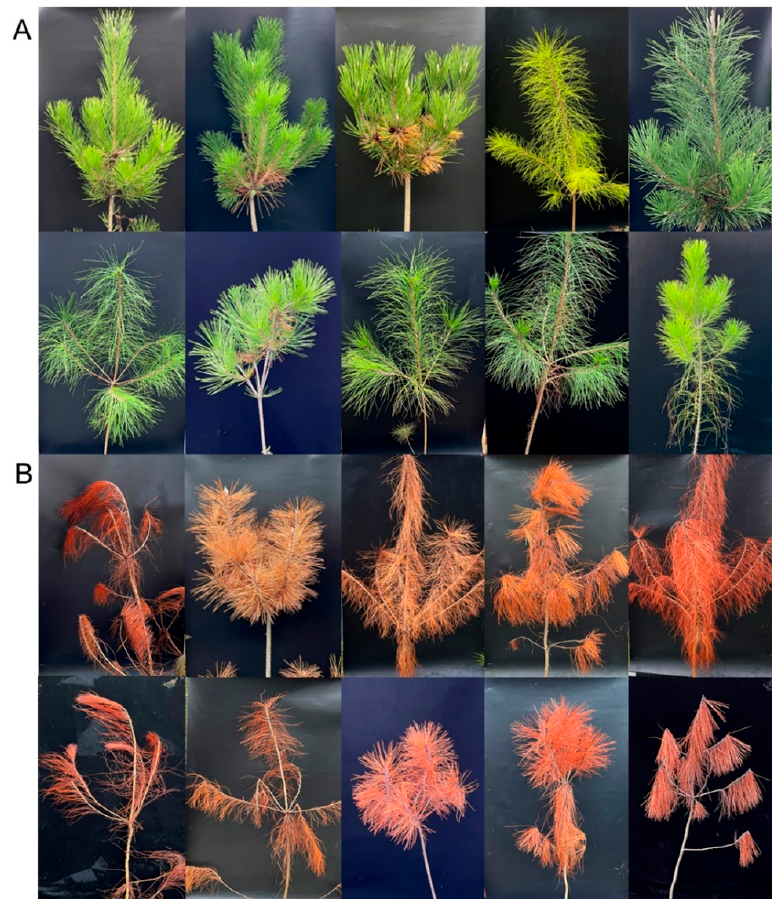
Figure 4. Effect of fluopyram SC application on pine wilt disease in the laboratory. These seedlings were treated with fluopyram DP ( A ) and water ( B , control) for the prevention effect test in the laboratory, and the photos were taken at the end of the observation.